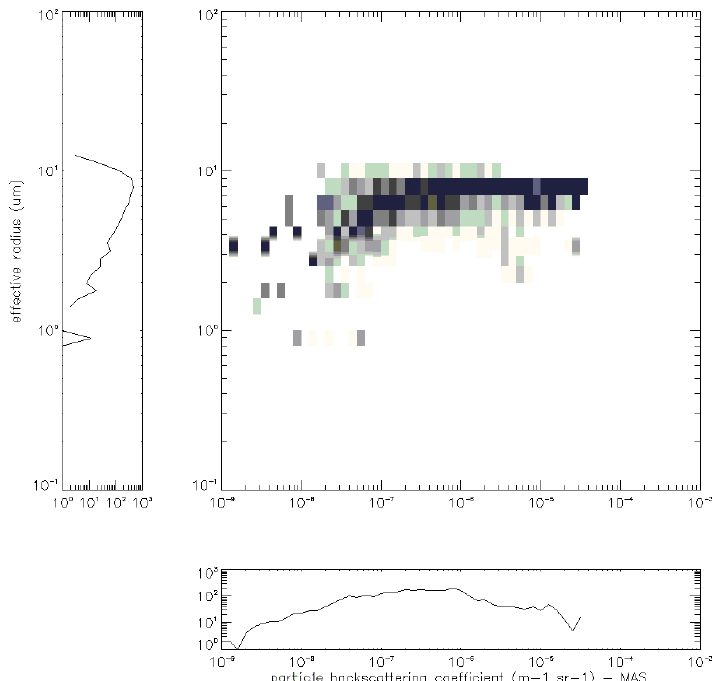
Fig. 9. Observation frequency histogram for β measured by the backscattersonde (horizontal) and for the particle effective radius (vertical). The central panel shows, in arbitrary units color coded in gray scale, the joint probability density distribution for the two